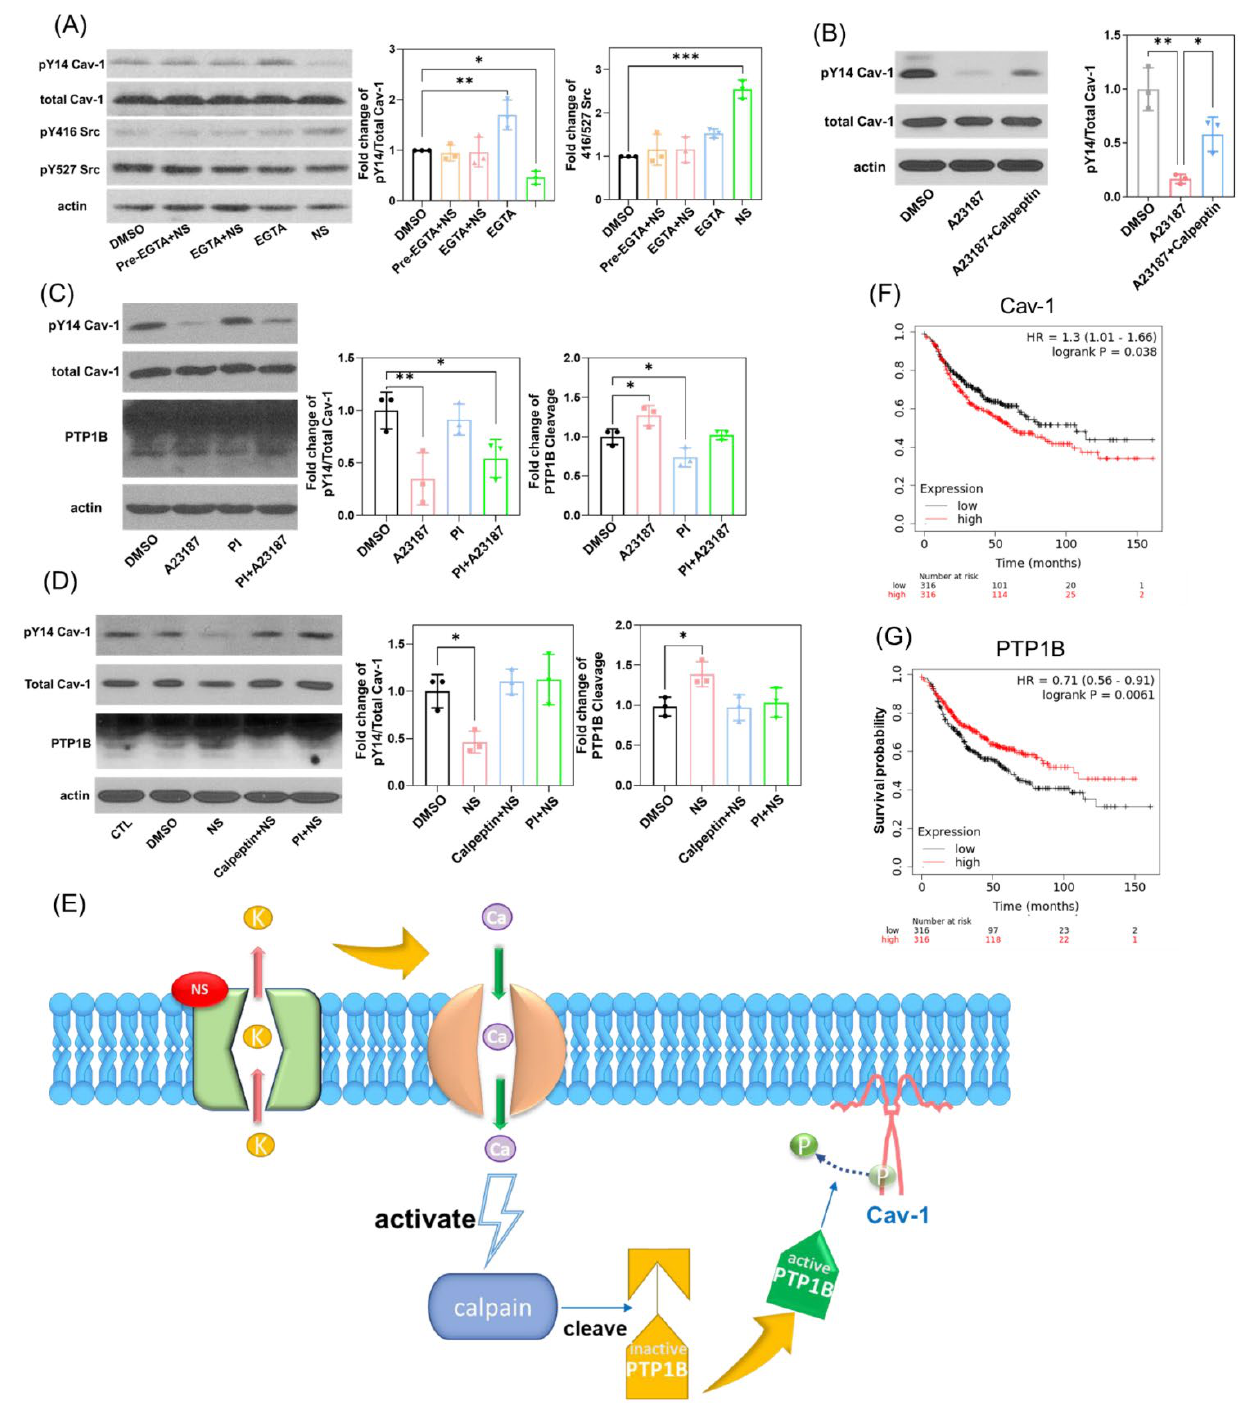
Figure 3. Kv11.1 activator NS1643 activates tyrosine phosphatase PTP1B, resulting in dephosphoryla- tion of Cav-1. ( A ) MDA-MB-231 cells treated with DMSO, 50 µ M NS1643, and 10 µ M EGTA for 30 min were lysed and subjected to Western blotting. Lane 2 are cells pretreated with 10 µ M EGTA for 15 min before adding NS1643. EGTA treatment prevented Cav-1 dephosphorylation and Src activation induced by NS1643, suggesting that the effect is calcium dependent. ( B ) MDA-MB-231 cells treated with DMSO, 5 µ M calcium Ionophore A23187, and 20 µ M calpain inhibitor calpeptin for 30 min were lysed and subjected to Western blotting. Calpeptin partly blocked Cav-1 phosphorylation induced by A23187. ( C ) MDA-MB-231 cells treated with DMSO, 5 µ M calcium Ionophore A23187, and 16 µ